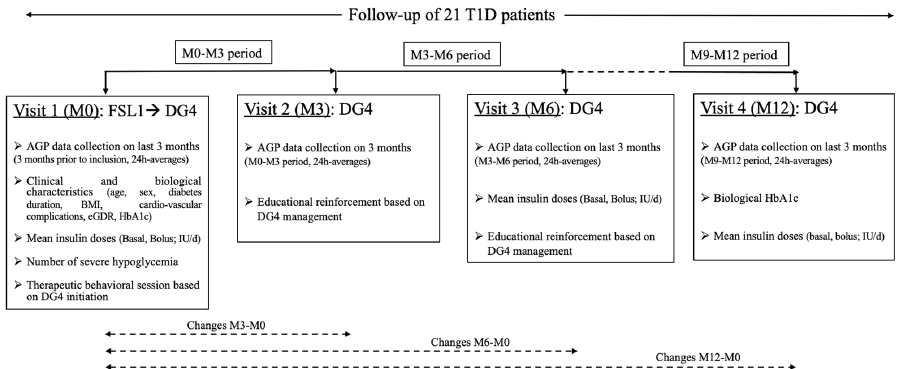
Figure 1. Study design. Abbreviations : AGP, Ambulatory Glucose Profile; BMI, body mass index; eGDR, estimated glucose disposal rate; FSL1, FreeStyle Libre version 1; DG4, Dexcom G4 platinum; HbA1c, plasma glycated hemoglobin A1c; T1D, type 1 diabetes.